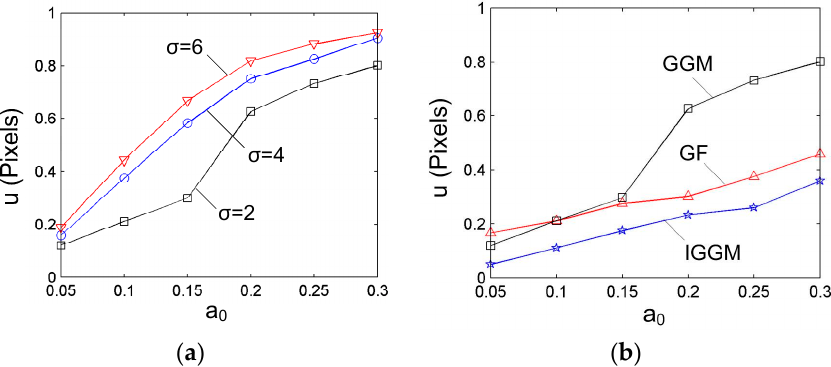
Figure 3. Uncertainty analysis for center computation: ( a ) Uncertainty values using the gray-gravity method (GGM) at different simulation parameters; ( b ) Comparison of the center uncertainty using different center extraction methods.